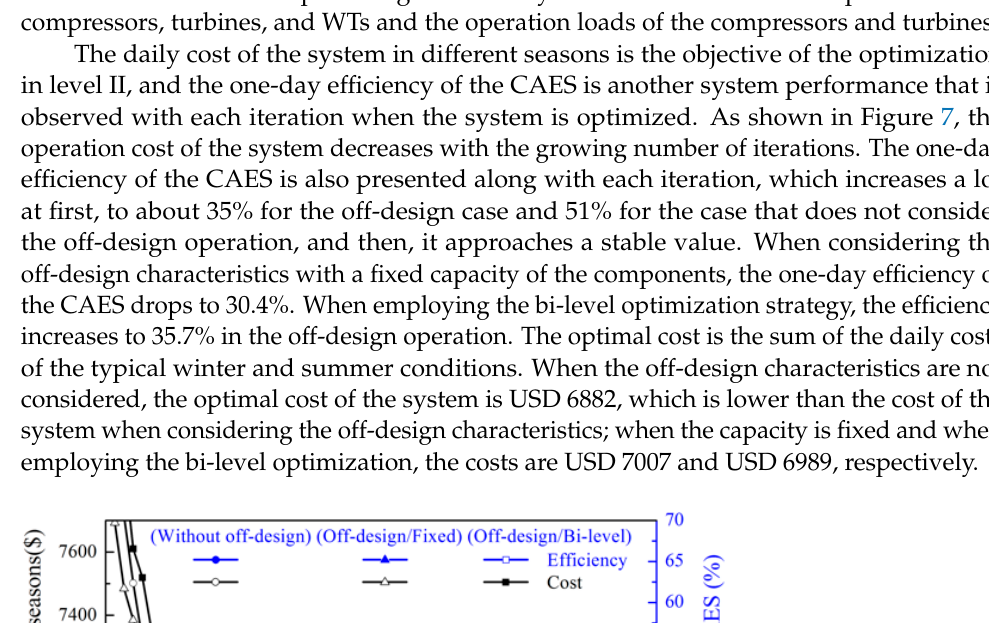
Figure 6. Inputting data in winter.